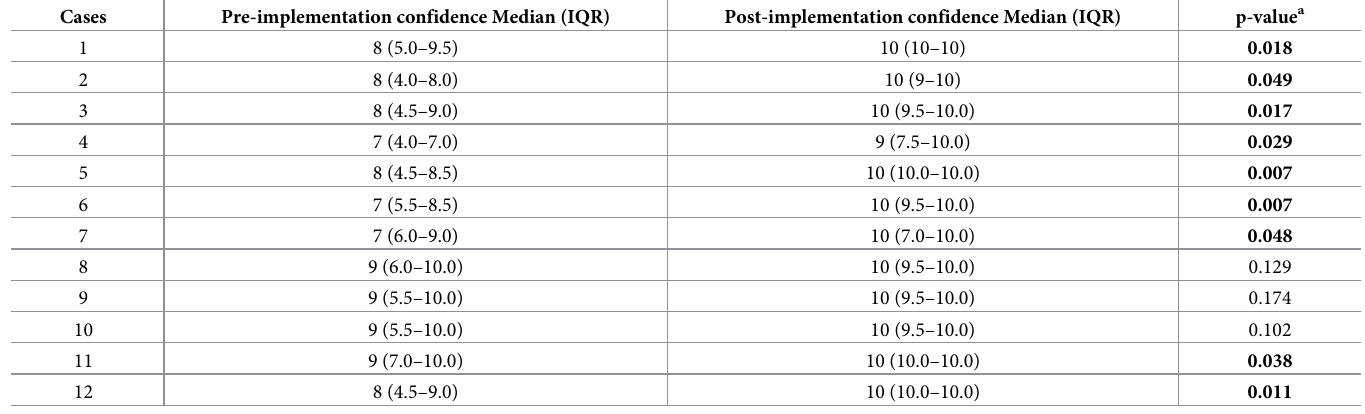
study, there was a decreased proportion of CT head scans performed, increased guideline adherence and an increase in the confidence levels of the MOs to indicate a CT head scan in cases of THI. Table 6. Confidence of the ED attending physicians in relation to the 12 case